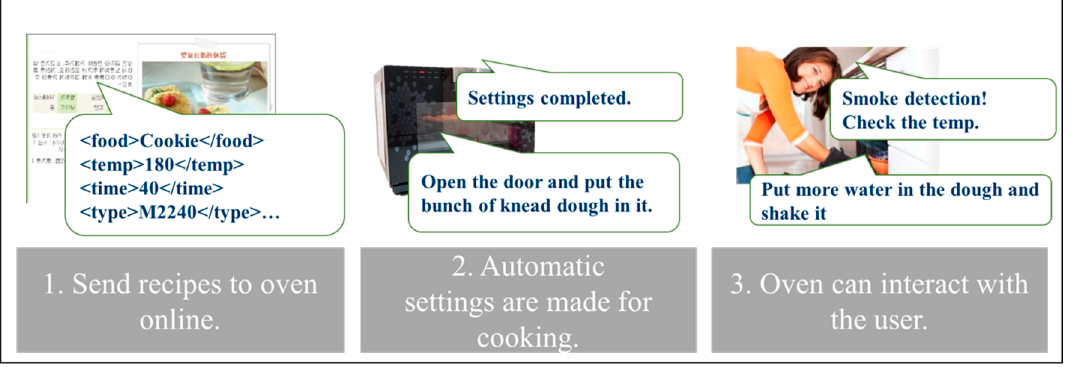
Figure 9. An example scenario of oven: ‘Oven never fails to cook!’.